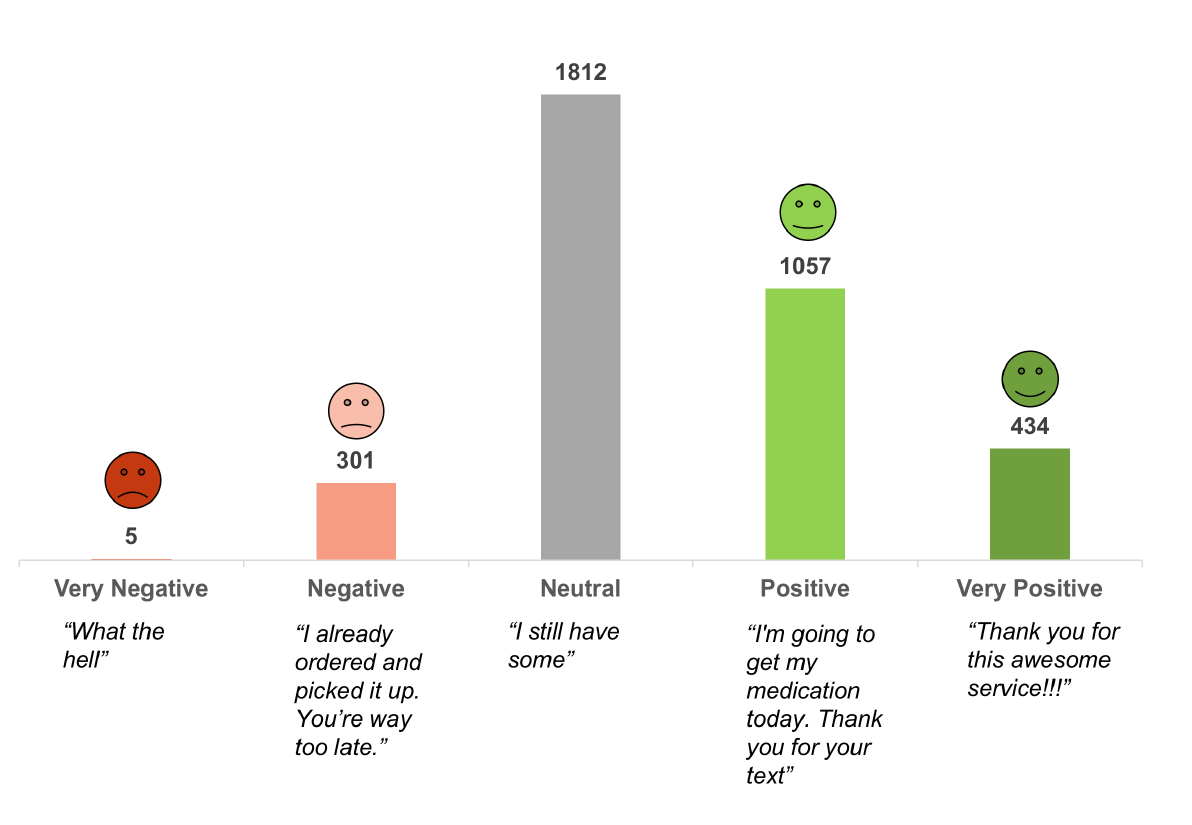
Figure 5. Sentiment in patient